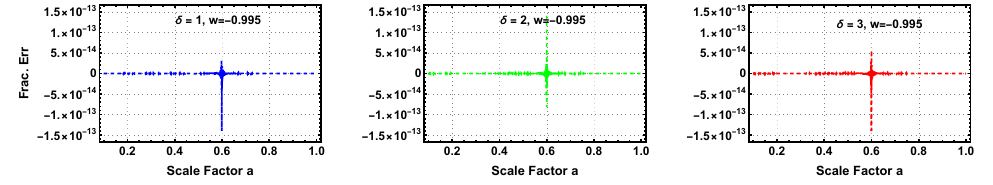
Figure 14. The fractional error for the second Friedmann constraint with w = − 0.995 and δ = 1, 2, and 3. The spikes at a ≈ 0.6 are due to the denominator passing through